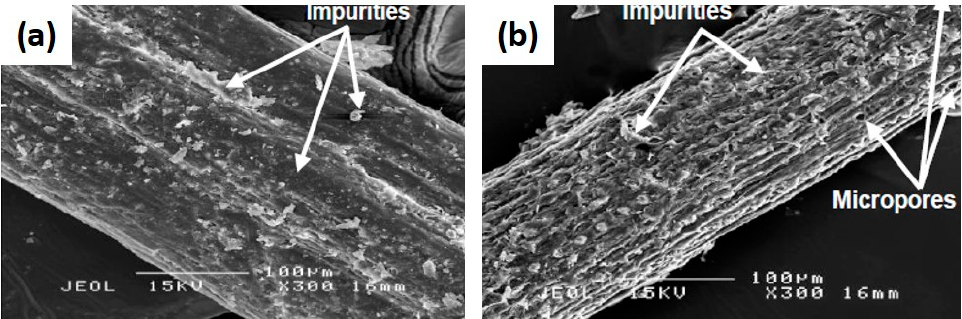
Figure 7. Superheated steam treatment method of application in ( a ) untreated ( b ) and treated OPMF.